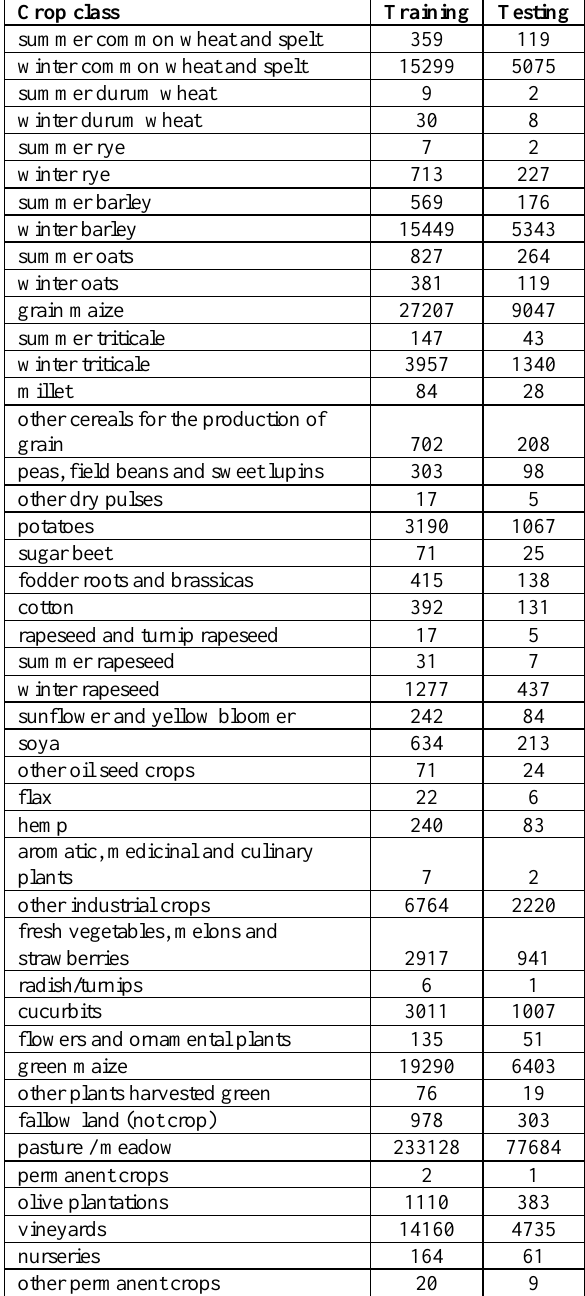
Table 6. Numerosity of each crop class in the training and testing